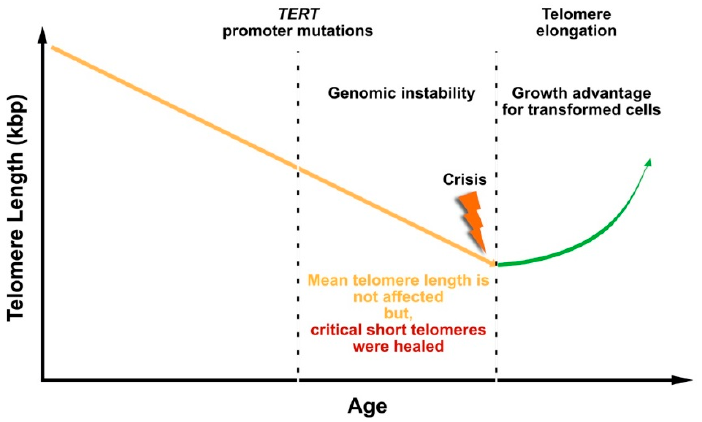
Figure 3. TERT promoter mutations are frequently involved in carcinogenesis and represent one way of telomerase activation.